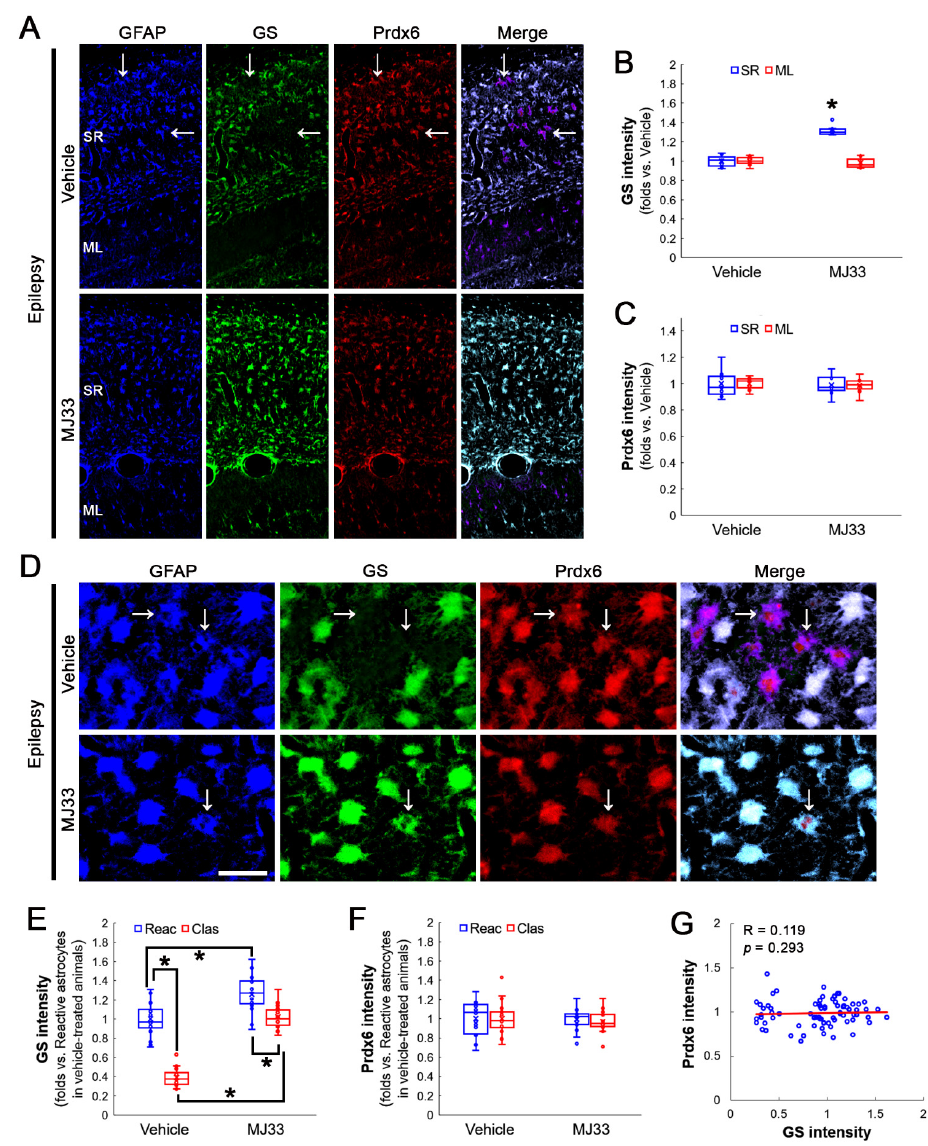
Figure 6. Effects of MJ33 on GS and Prdx6 expressions and clasmatodendritic degeneration of CA1 astrocytes in chronic epilepsy rats. As compared to a vehicle, MJ33 increases GS levels in reactive astrocytes and clasmatodendritic (vacuolized) astrocytes (arrows) within the stratum radiatum (SR) of the CA1 region, while it does not influence astroglial Prdx6 levels in this region. MJ33 does not influence GS and Prdx6 expressions in the molecular layer (ML) of the dentate gyrus. ( A )